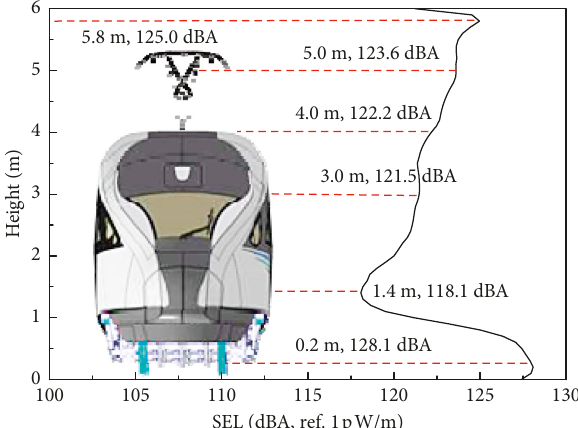
Figure 10: Vertical distribution of the exterior noise sources of a high-speed train running at 350km/h (500–5000